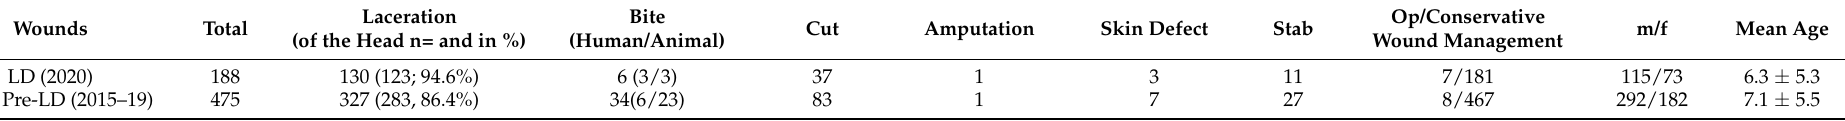
Table 6. Distribution of wounds during LD and the pre-LD